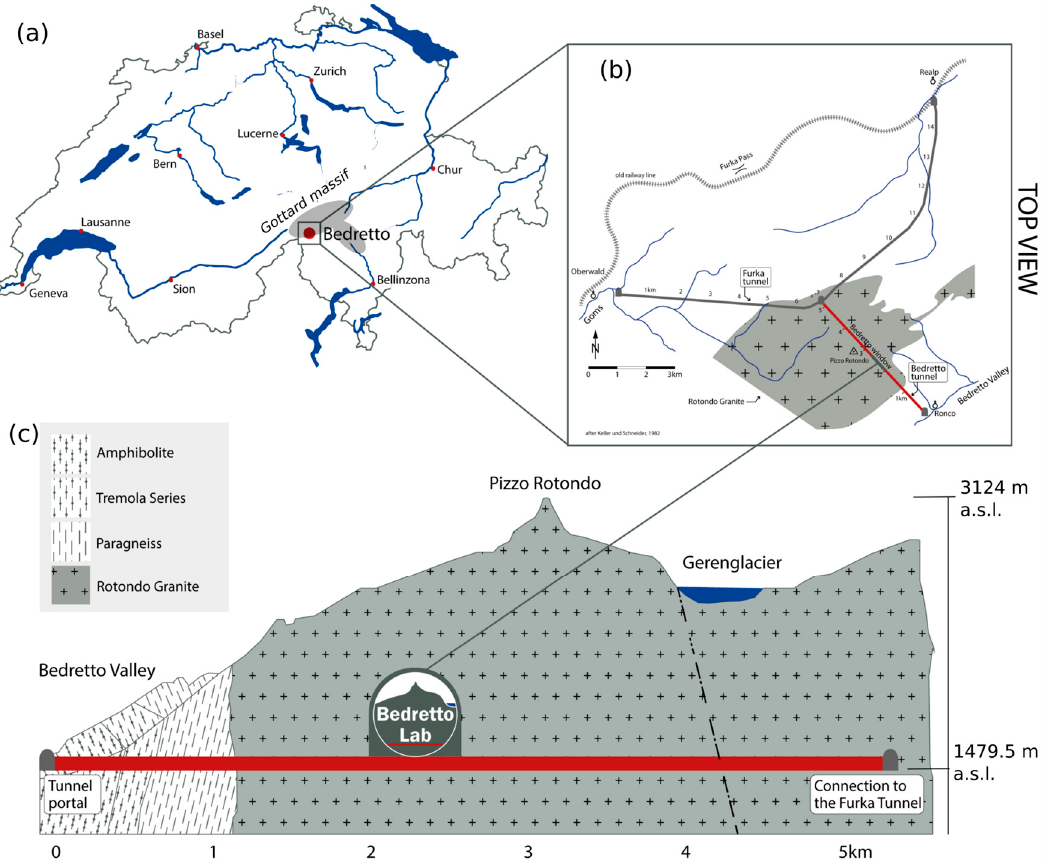
Figure 4. Location and setting of the Bedretto Underground Laboratory for Geosciences and Geoen- ergies: ( a ) geographical overview of Switzerland; ( b ) map view of local setting with regard to the Furka Tunnel; and ( c ) cross section after Keller and Schneider, 1982. The Bedretto tunnel is shown as a red line.